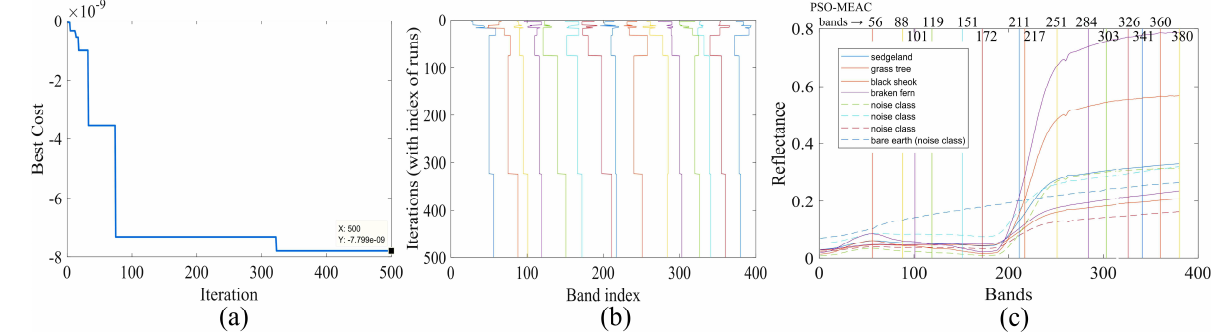
Figure 3. Optimal band selection: ( a ) a plot demonstrating variation of cost criterion with the PSO-MEAC iterations, ( b ) bands selected in each iteration, and ( c ) a plot of the identified optimal bands overlayed on the class spectra. The cost criterion was progressively minimized with the number of iterations. The variations of band position with the index of runs in every iteration provide insights into the functioning of PSO-MEAC. Overall, the PSO-MEAC-identified bands are well distributed over the key wavebands with maximal variation between inter-class reflectance.